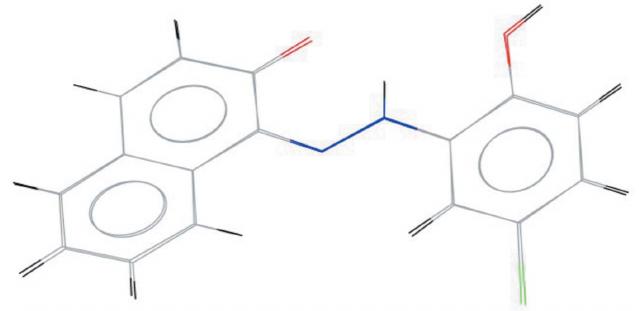
Figure 2 Overlay image of the two molecules in the asymmetric unit of the title compound.